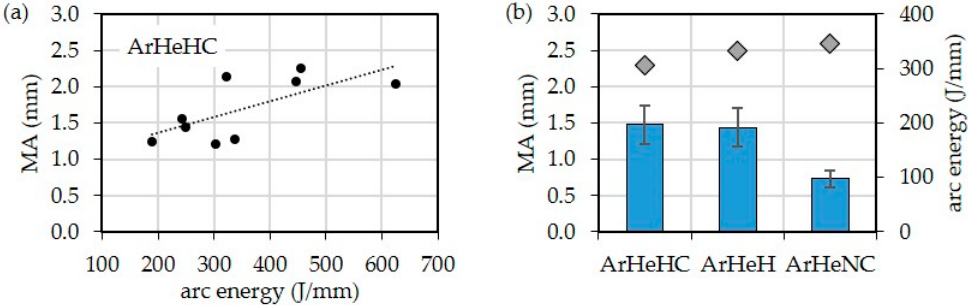
Figure 12. Machining allowance MA of walls depended on ( a ) arc energy and ( b ) shielding gas.